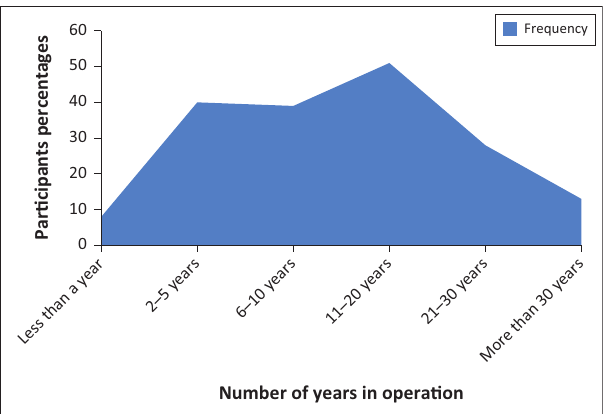
FIG URE 5: Total number of years the business has been